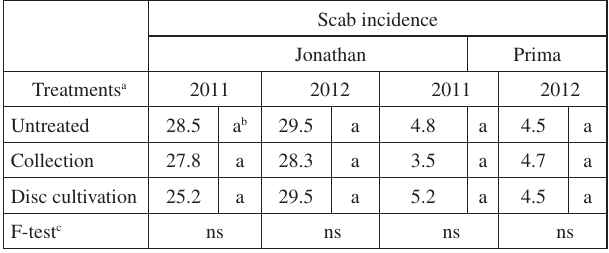
Table 1. Scab incidence (%) in autumn in three sanitation treatments at farm-scale level on cv. Jonathan and Prima at Eperjeske in 2011 and